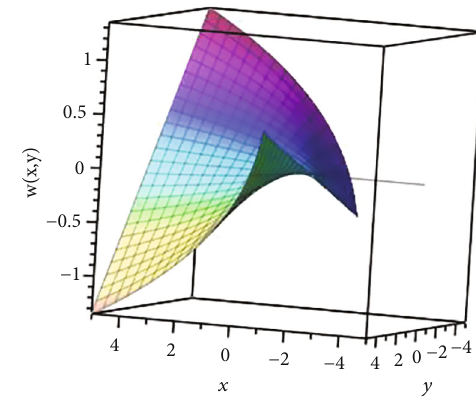
Figure 13: 3D complex plot of (51) for α = 1